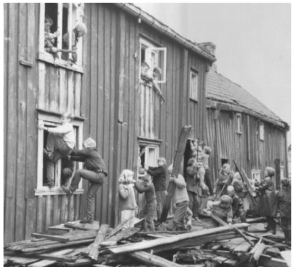
Figure 2. Svartlamon in 1964 (Trondheim Municipal Archive